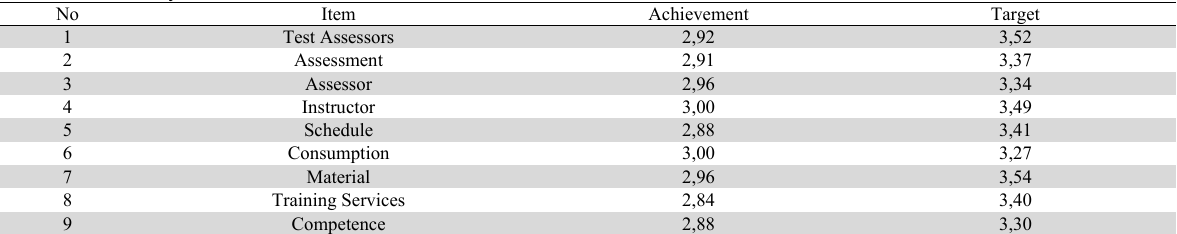
Satisfaction survey